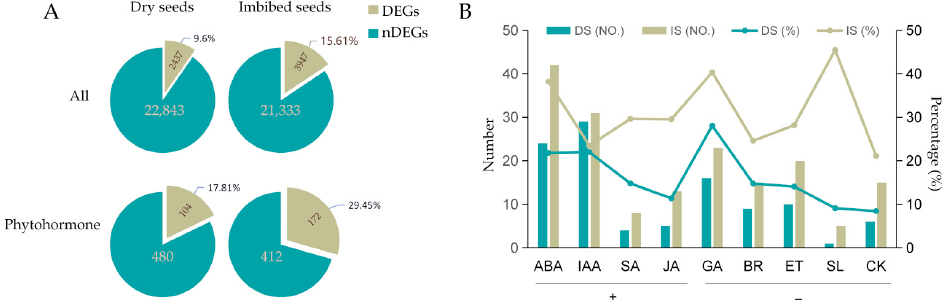
Figure 3. Phytohormone-related DEGs were highly enriched in dog1–2 . ( A ) The percentage of the total DEGs and the phytohormone-related DEGs in dry and imbibed seeds. DEGs, differentially expressed genes. nDEG, not DEGs. ( B ) The number and percentage of DEGs in the indicated phytohormone pathways in dry and imbibed seeds. “+” denotes the phytohormones that induce seed dormancy or inhibit seed germination; “ − ” denotes the phytohormones that release seed dormancy or promote seed germination. DS, dry seeds; IS, imbibed seeds.